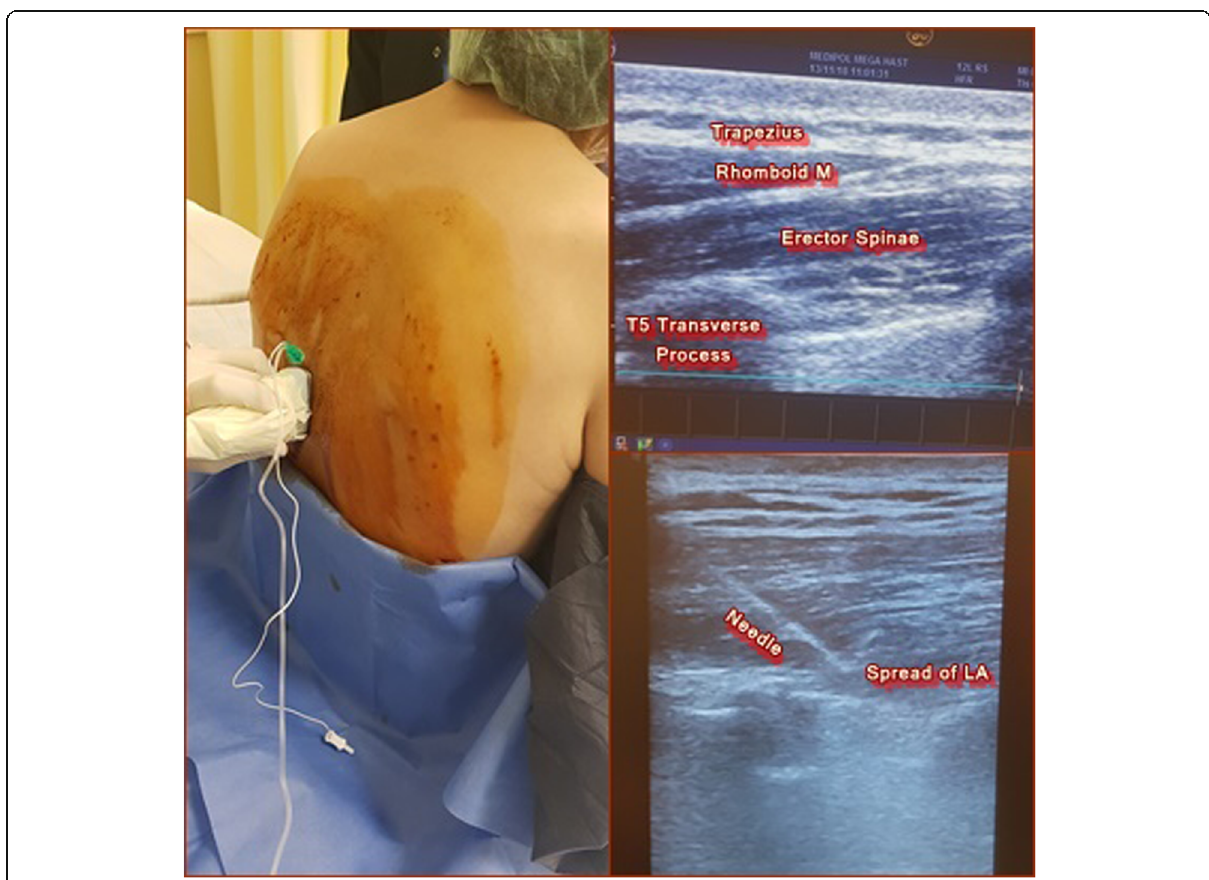
Fig. 1 a Block preparation. b Sonographic anatomy. c Spread of local anesthetic (below erector spinae muscle, above the transverse